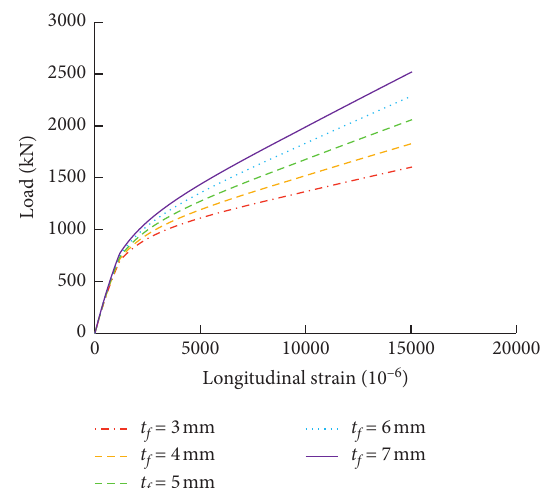
Figure 9: Effect of thickness of glass fiber